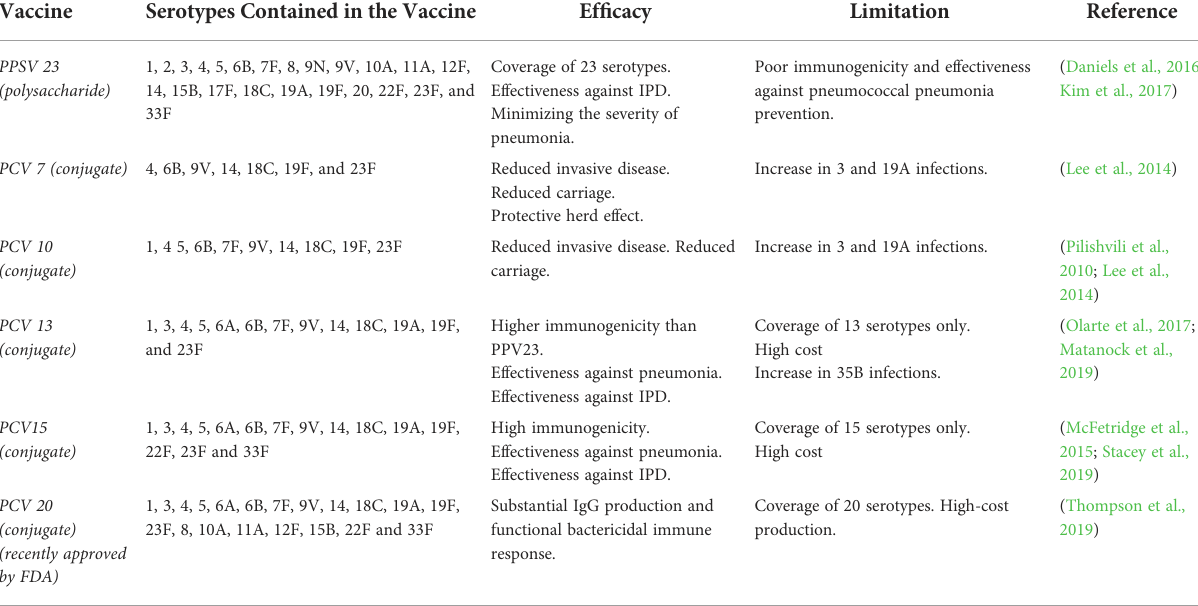
TABLE 2 Capsular Polysaccharide-based vaccines.